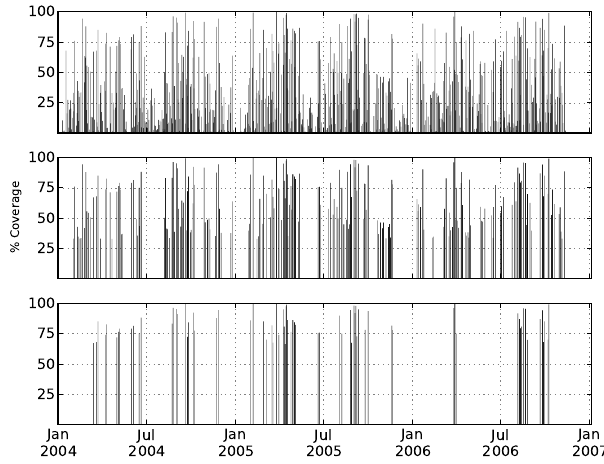
Fig. 4. Precent spatial coverage of MODIS Aqua satellite data in the Gulf of Maine. Top panel shows arial coverage of all satellite images between 2004–2006. In the middle panel, we depict the coverage of image pairs (described earlier), where both images are 2–6 day apart and have at least 30% arial coverage. The bottom panel is the same as the middle one, but shows images with at least 60%